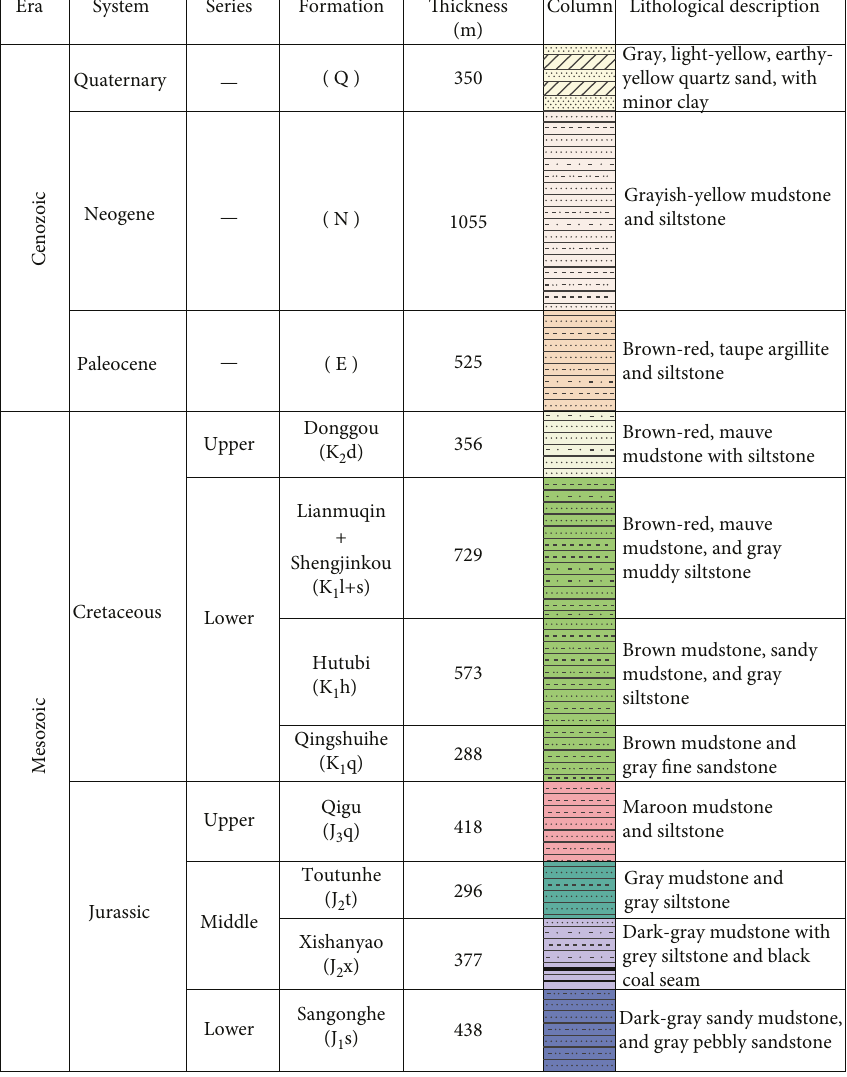
Figure 3: Lithological column of the target injection well.